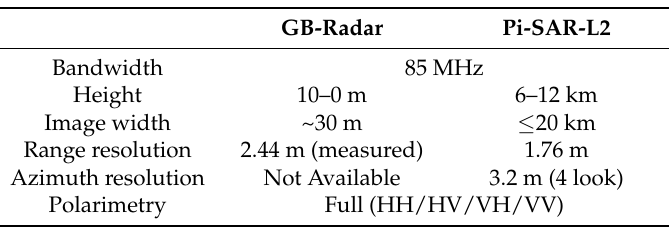
Table 2. Specifications of GB-radar and Pi-SAR-L2.